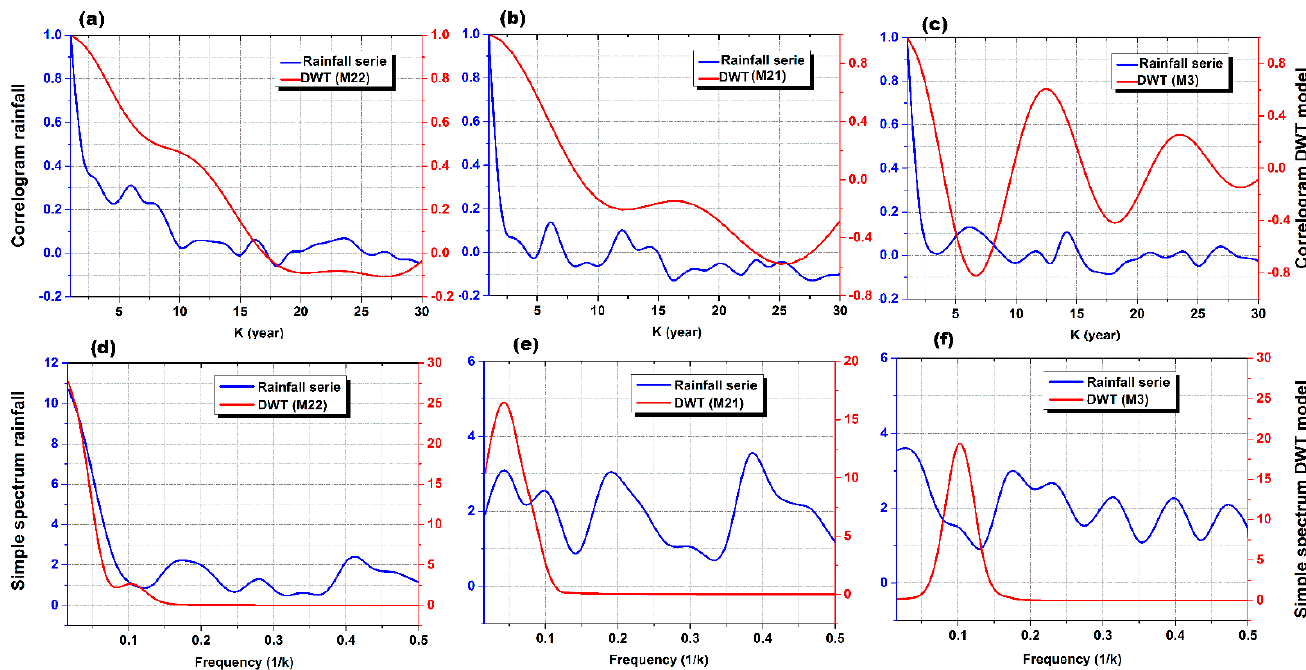
Figure 10. Correlogram of ( a ) Oued Taria, ( b ) Azazga, ( c ) Ain Beida rainfall (blue) and DWT model (Red) and simple spectrum of ( d ) Oued Taria, ( e ) Azazga, ( f ) Ain Beida rainfall (blue) and DWT model (Red).